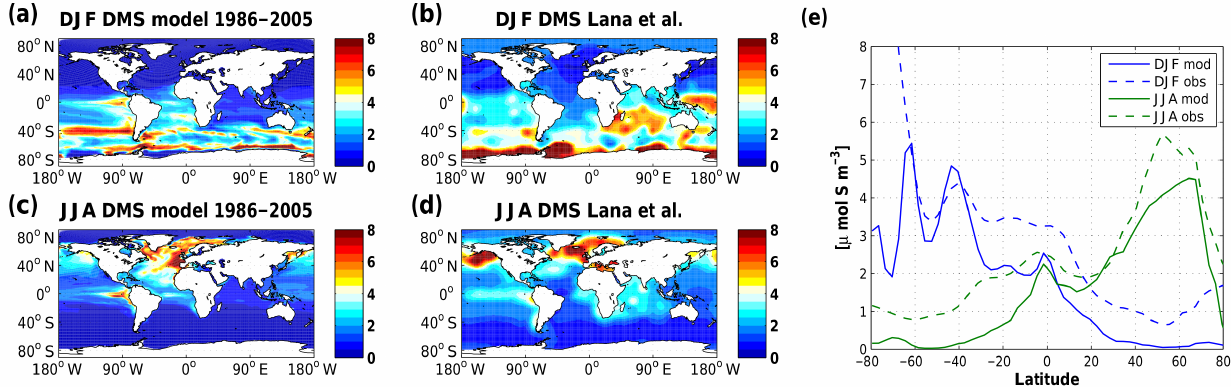
Figure 2. Surface DMS concentration (µmolSm − 3 ) during (a, b) boreal winter (DJF) and (c, d) boreal summer (JJA). Results for the BASE historical simulation averaged over 1986 to 2005 are shown in panels (a) , (c) and the observation-based climatology by Lana et al. (2011) is displayed in panels (b) , (d) . Panel (e) shows the zonal means of each field presented in panels (a) – (d)